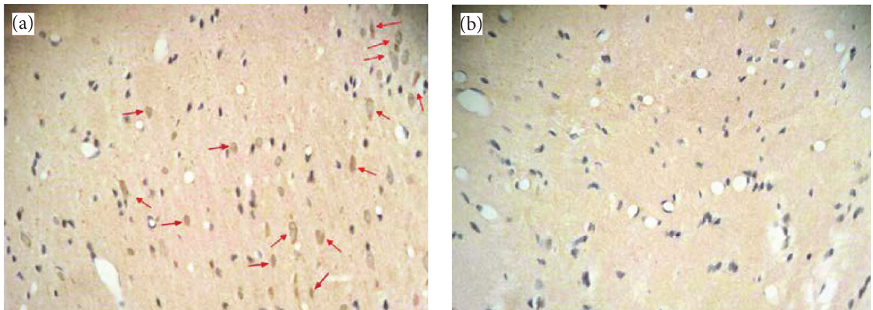
Figure 2: Immunohistochemical findings. (a) Treatment group. Intravenously transplanted bone marrow stromal cells 7 days after ischemia have migrated to the hippocampal area around the injured site. The arrows indicate Brdu-positive bone marrow stromal cells. (b) Vehicle group which received PBS 7 days after ischemia. There is no Brdu-positive bone marrow stromal